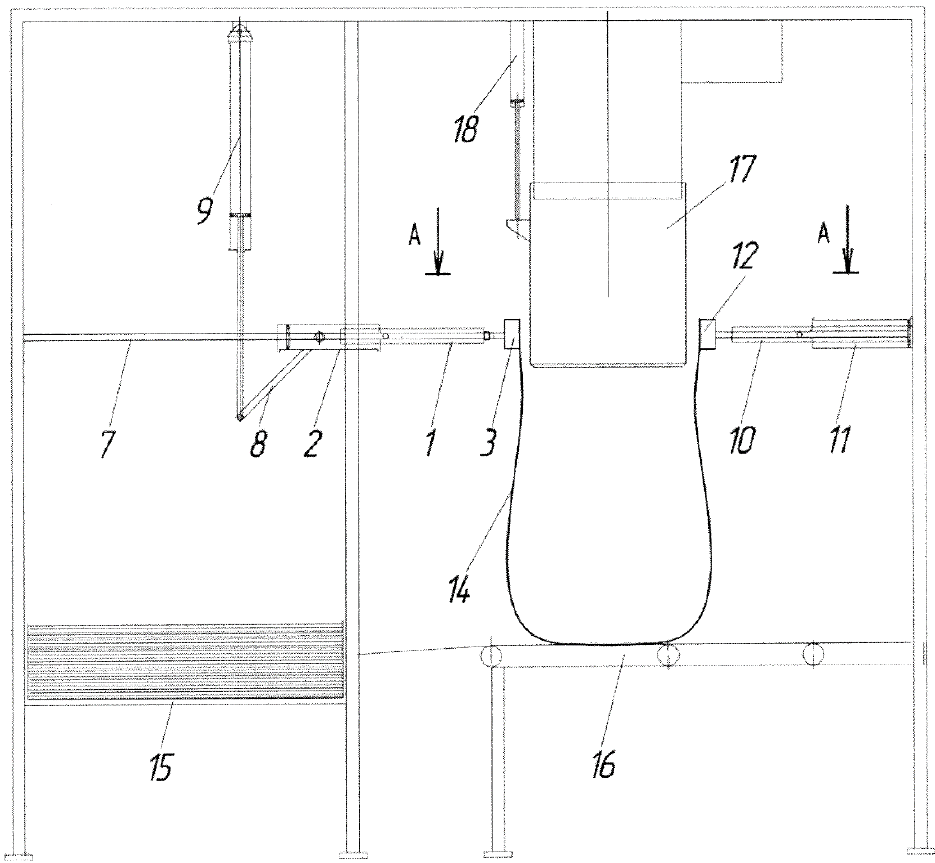
Figure 15. Scheme of the unit for automatic packaging of bulk materials.